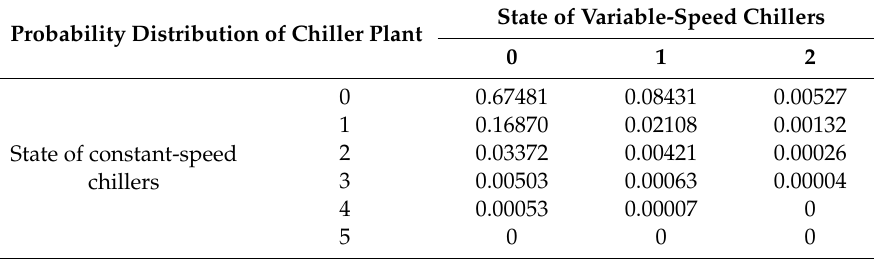
Table 4. An example of the probability distribution of a chiller